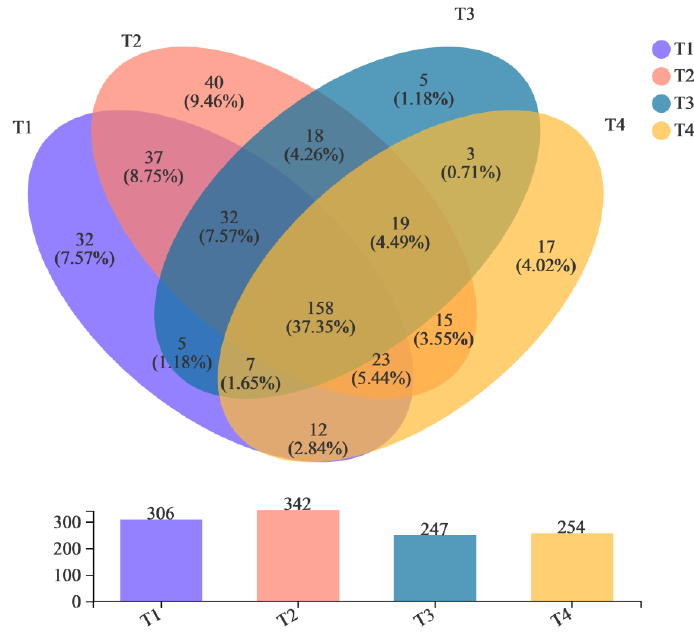
Figure 1. Venn diagram of bacterial communities.